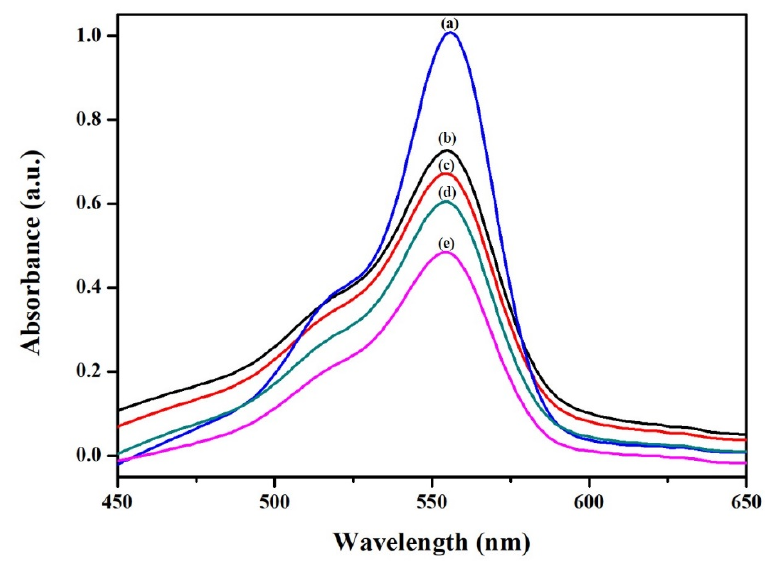
Figure 8. UV-Vis spectra of mixture with different conditions: ( a ) Control sample 1, 0.012 mM Rh-B + 25 mM FeSO 4 ; ( b ) 0.012 mM Rh-B + 0.15 mM PNI-C 60 + 25 mM FeSO 4 + 500 mM H 2 O 2 ; ( c ) 0.012 mM Rh-B + 0.10 mM PNI-C 60 + 25 mM FeSO 4 ; ( d ) 0.012 mM Rh-B + 0.05 mM PNI-C 60 + 25 mM FeSO 4 + 500 mM H 2 O 2 ; ( e ) Control sample 2, 0.012 mM Rh-B + 25 mM FeSO 4 + 500 mM H 2 O 2 .